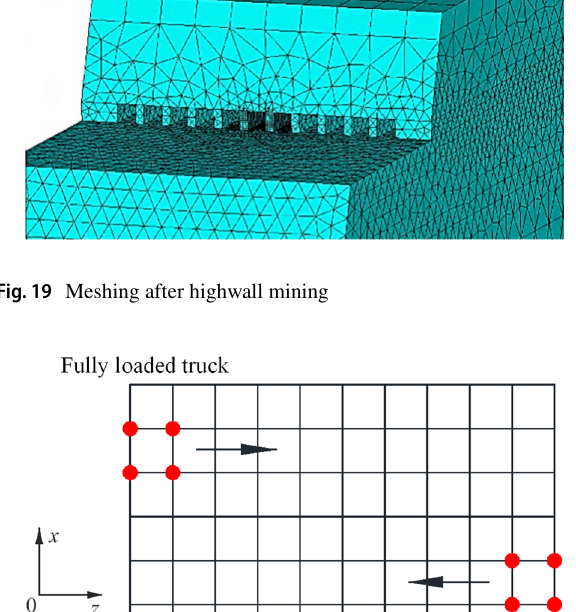
Fig. 18 Global view of end slope